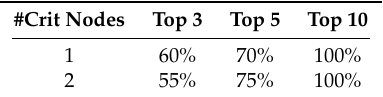
Table 5. Critical node identification success percentage when utilizing different top rank thresholds for relay and connectivity for the lifetime